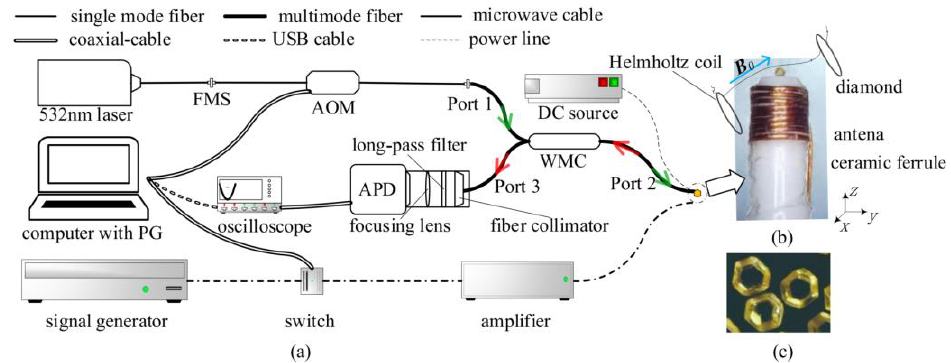
Figure 1. ( a ) Schematic of the all-fiber magnetometer setup. ( b ) A micro-diamond is attached on the tip of WMC’s Port 2 with an eight-turn copper coil twining around the fiber. A one-axis Helmholtz coil is settled near the micro-diamond to generate an auxiliary calibration magnetic field Ba. ( c ) The micro diamond with a diameter of 550 μm is observed under m icroscope.